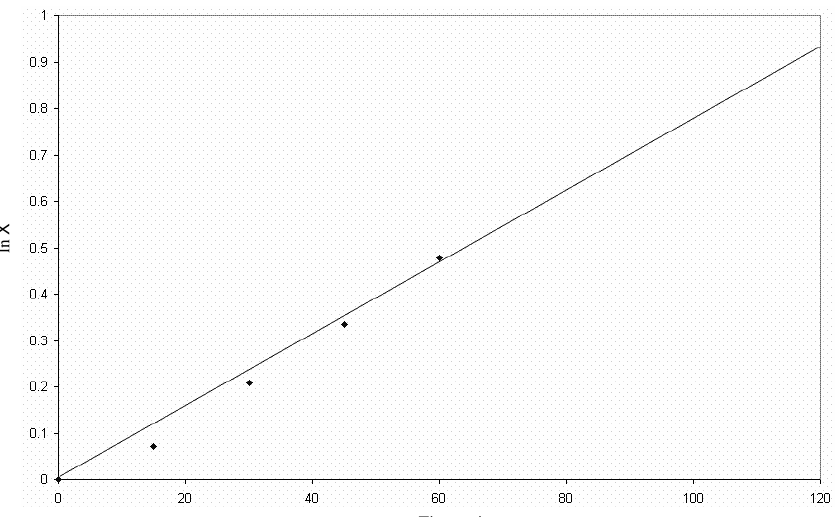
Figure 5. Represent calculation of diffusion coefficient (D) for